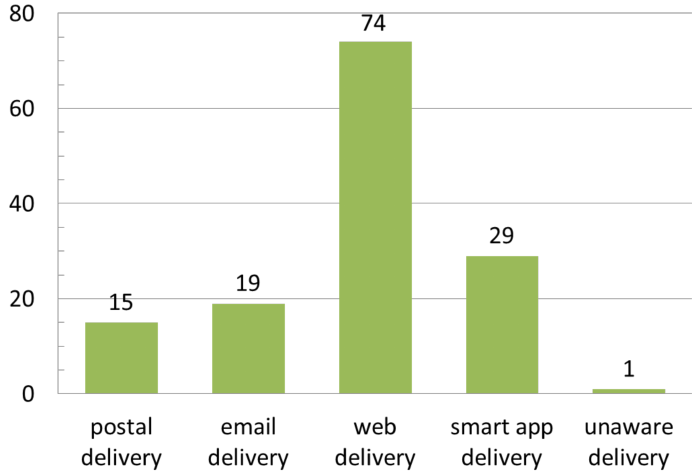
Figure 7. Chart representation of the results relative to the data delivery